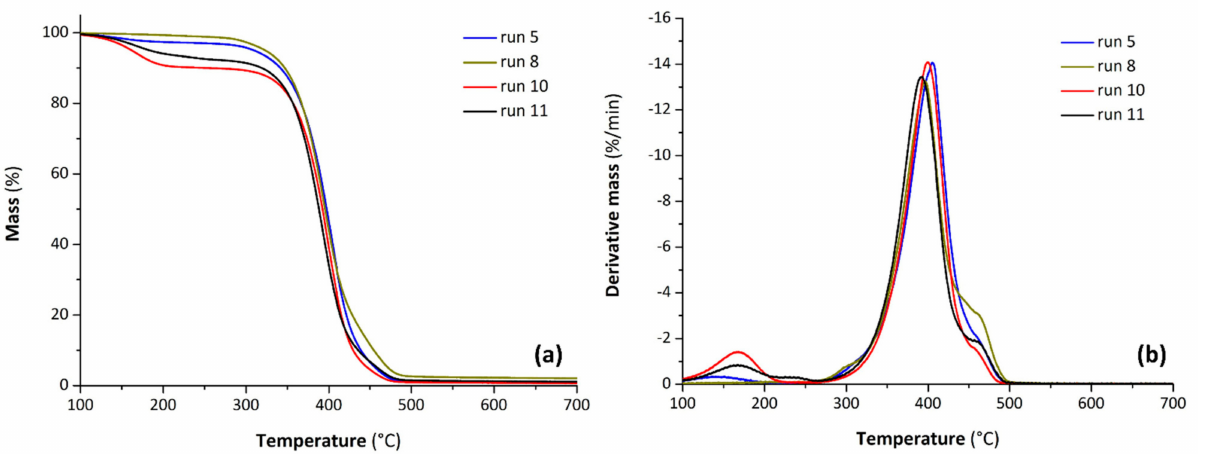
Figure 6. TGA (thermogravimetric analysis) ( a ) and DTG (derivate thermogravimetry) ( b ) curves for selected bio-polyols from CA (run 5, 8) and 3PBA (run 10,